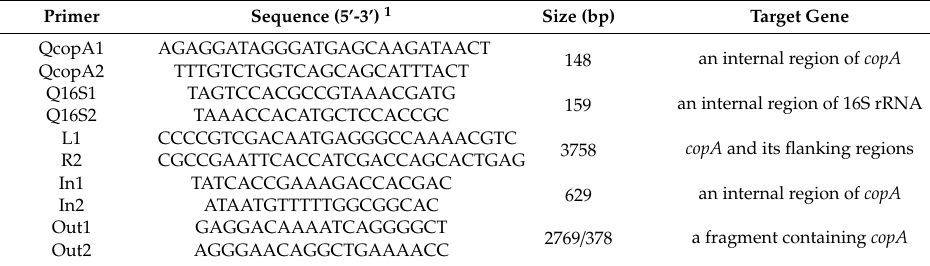
Table 3. Primers used in this